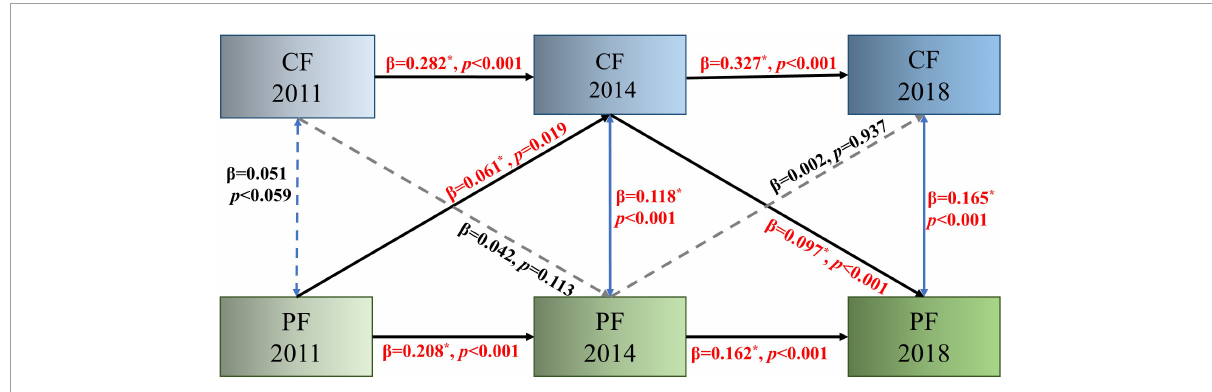
FIGURE2 Autoregressive cross-lagged model assessing bidirectional relationships between physical function and cognition over 3 years. Solid lines indicate significant associations, and dashed lines indicate non-significant associations. PF, physical function; CF, cognitive function, * p <